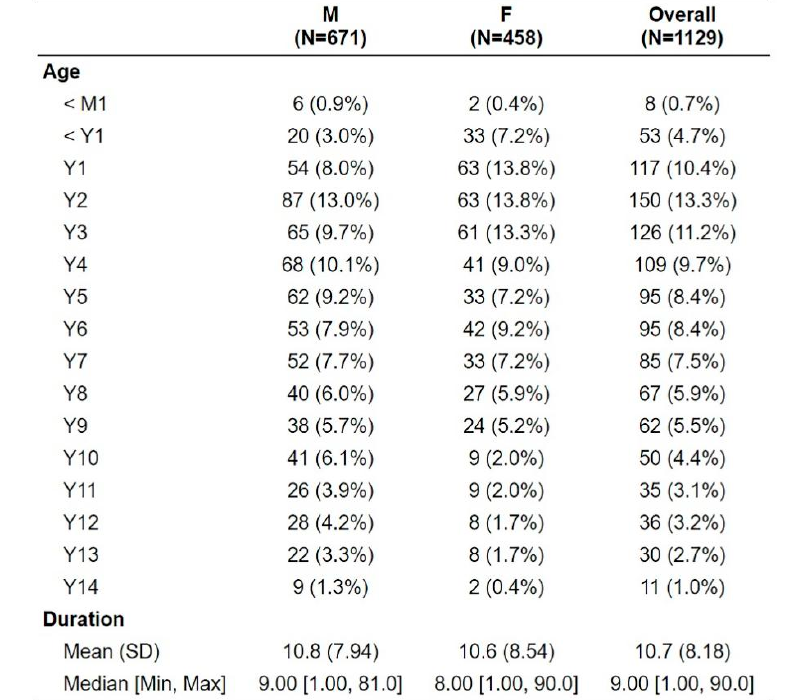
Figure 2. Gender and duration of pediatric orthopedics patients from 2006 to 2021. Legend : M = Male F = Female.